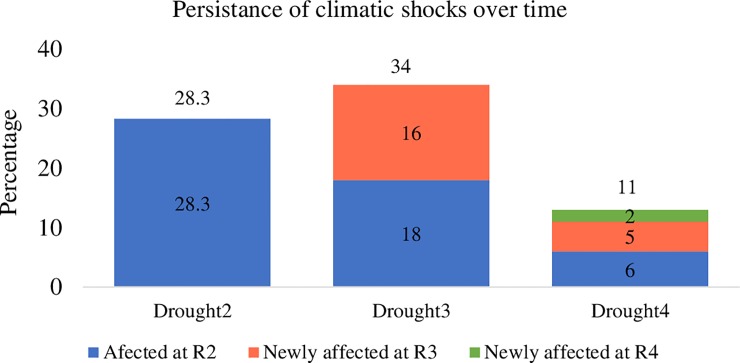
Patterns of drought over time, YL, Ethiopia.